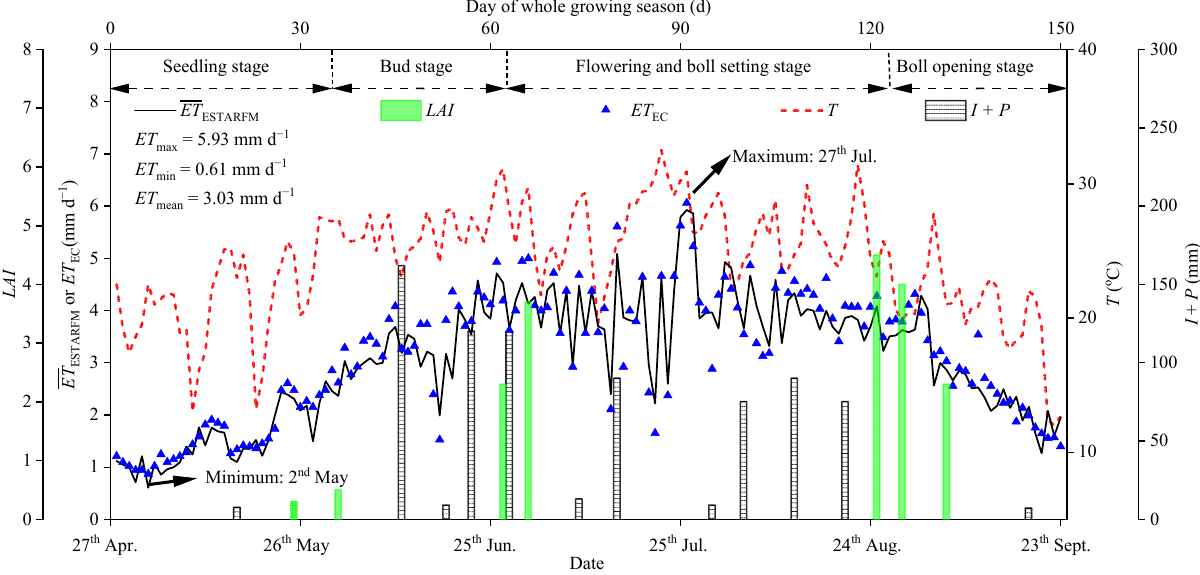
Figure 9. Dynamics of leaf area index ( LAI ), mean air temperature ( T ), total water supply of irrigation and precipitation ( I + P ), and daily evapotranspiration rate measured by an eddy covariance system ( ET EC ) in the Wulanwusu Agricultural Experimental Station and estimated by remote sensing fusion as an average over the entire Manas River Basin ( ESTARFM ) during the growing season (April–September) of cotton fields under film-mulched drip irrigation in 2012. The minimum ET ESTARFM (0.61 mm d − 1 ) was found in the seedling stage (2 May),